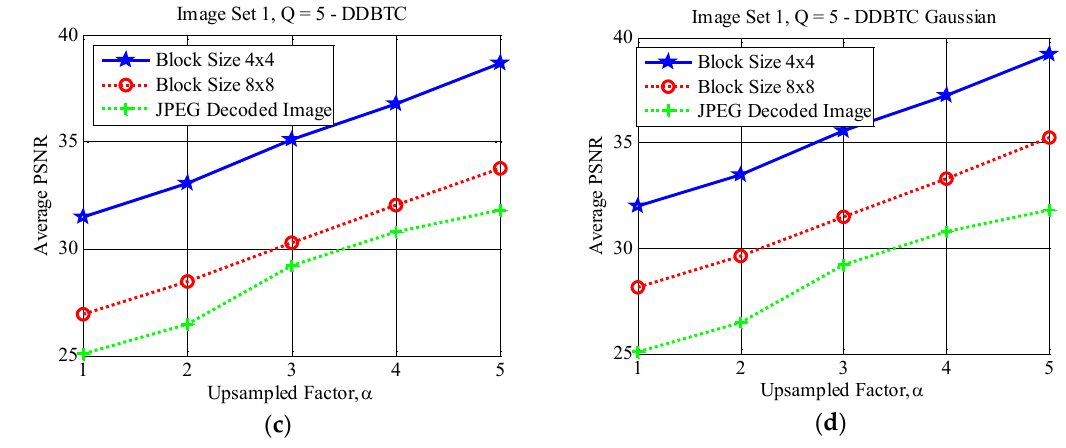
Figure 17. Effect of image block sizes on Image Set 1 with 𝑄 = 5 over ( a ) ODBTC; ( b ) EDBTC; ( c ) DDBTC; and ( d ) DDBTC Gaussian scheme.